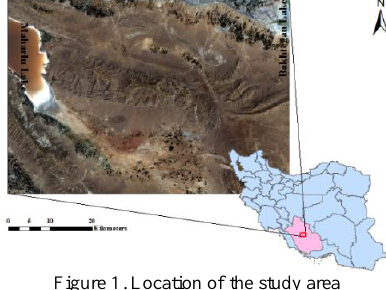
Figure 1. Location of the study area 2.2 Remotely sensed data